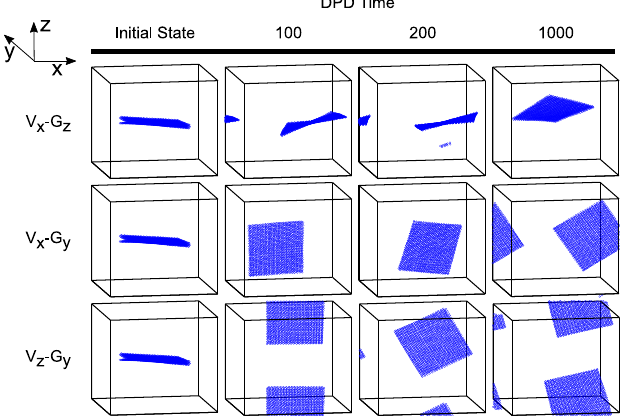
Figure 3. Snapshots of the clay platelets with time experiencing various flow directions. The applied shear-rate is 0.148 in DPD units and the flow of each row is defined in the figure; the velocity direction is shown by V direction and the velocity gradient direction by G direction . Reprinted from Gooneie et al. [195]. Copyright 2016, with permission from John Wiley & Sons Inc.